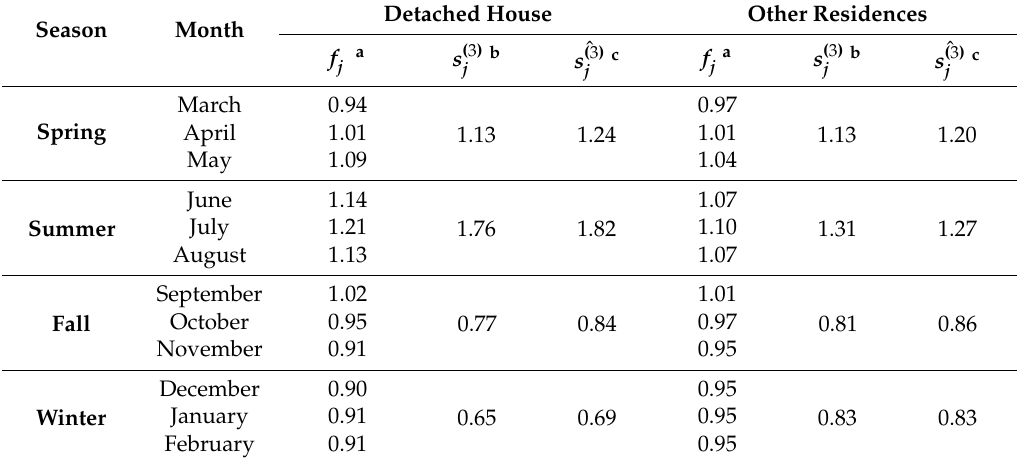
Table 5. Correction factors for detached houses and others